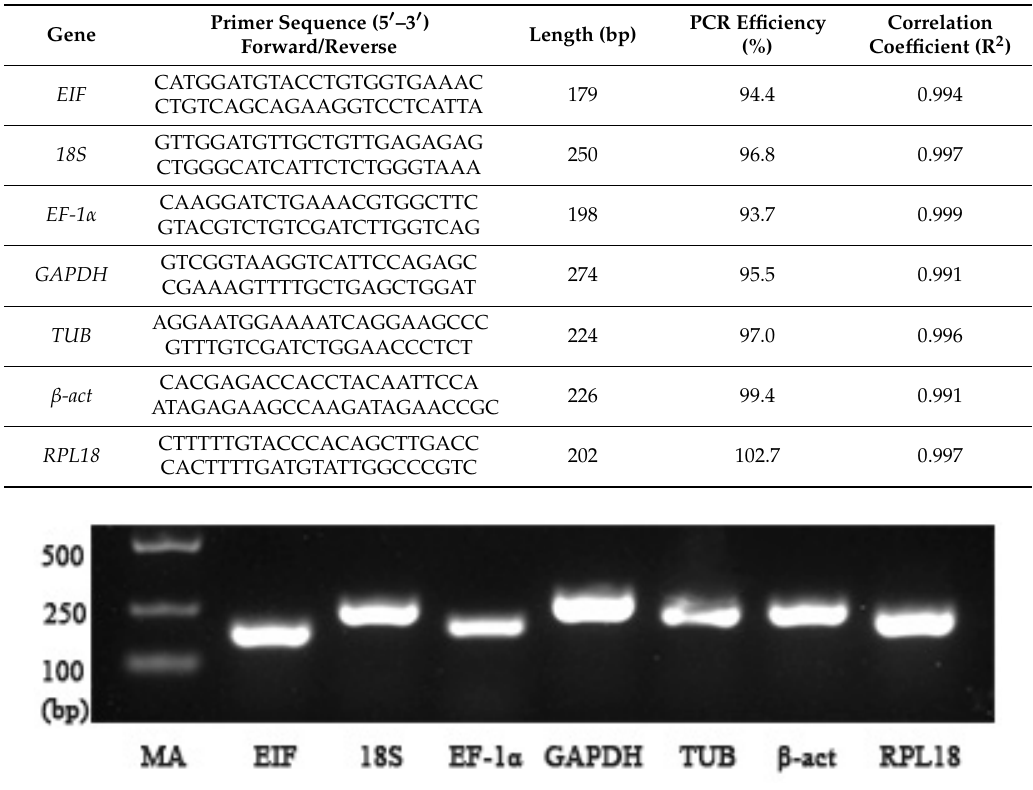
Figure 1. Agarose gel electrophoresis of qPCR primers amplification of the candidate reference genes using hepatopancreas cDNA as a template. MA means DNA marker DL2000, which is in the left side and shows their expected sizes. EIF —eukaryotic translation initiation factor 5A; 18S — 18S ribosomal RNA ; EF-1 α — elongation factor-1 α ; GAPDH — glyceraldehyde-3-phosphate dehydrogenase ; TUB — α -tubulin ; β -act — β -actin ; RPL18 — Ribosomal protein L18 . Table 1. Primer pairs for qPCR of candidate reference genes. EIF—eukaryotic translation initiation factor RPL18—Ribosomal protein L18.